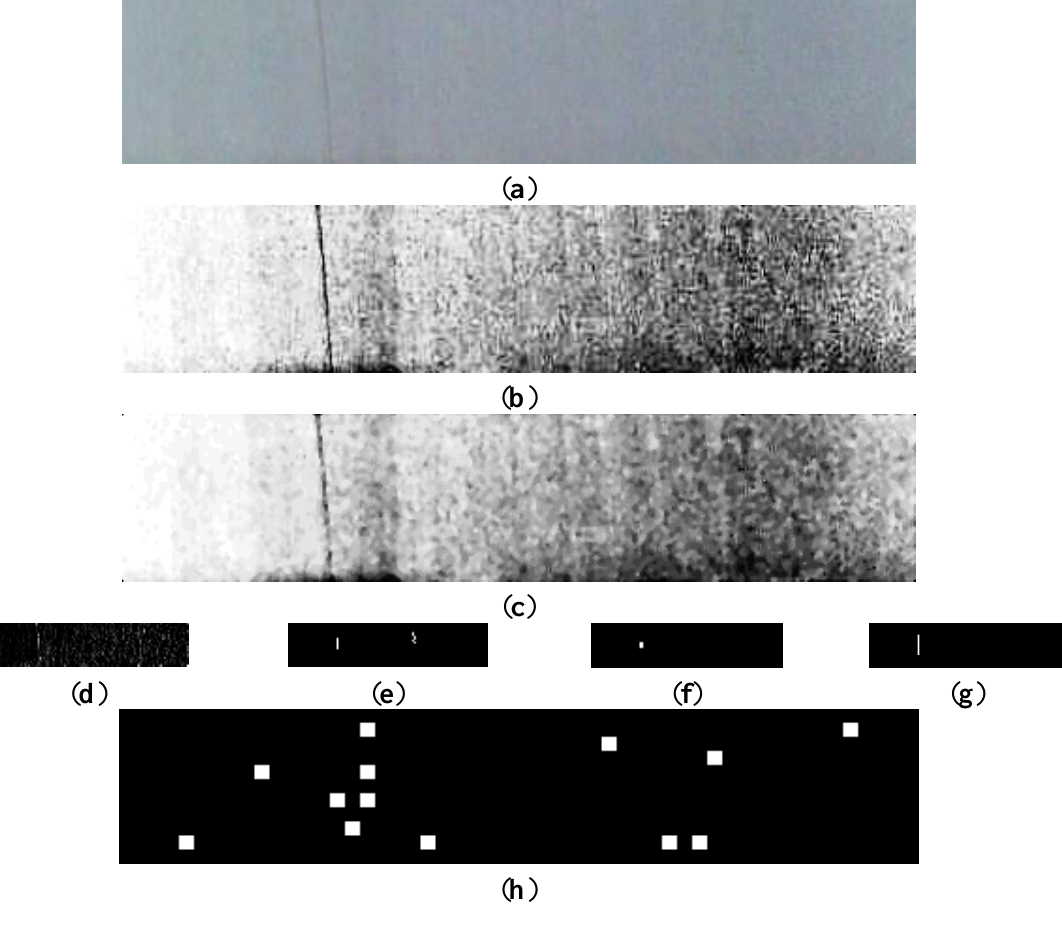
Figure 14. ( a ) Raw image; ( b ) Effect of image equalization; ( c ) Effect of median filtering; ( d ) LH2 wavelet coefficients ; ( e ) Binarization image ; ( f ) Image after erosion; and ( g ) Image after two dilations; ( h ) Detection result using